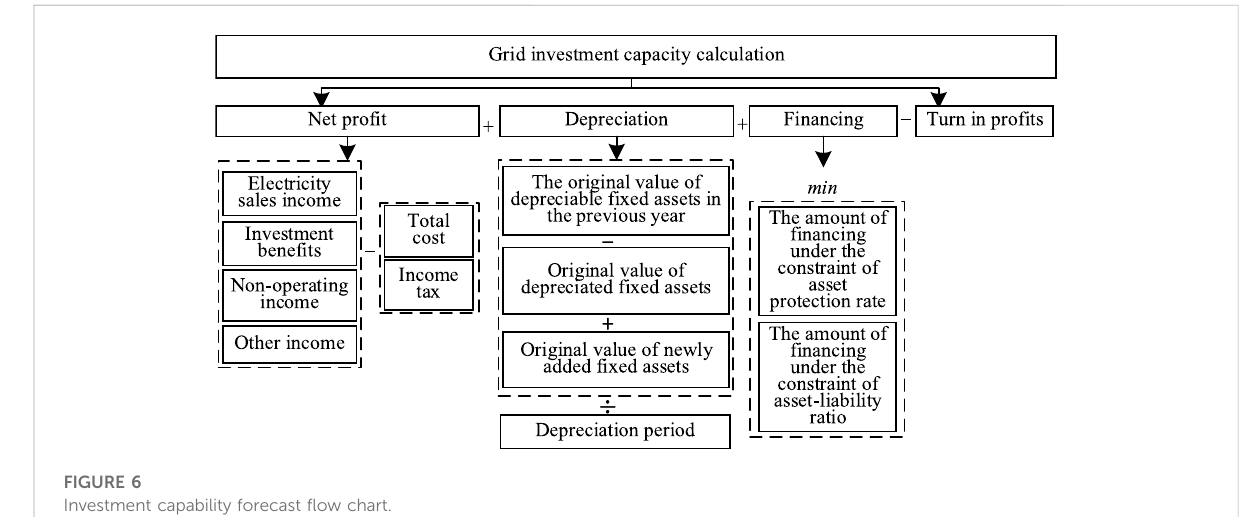
FIGURE 6 Investment capability forecast fl ow